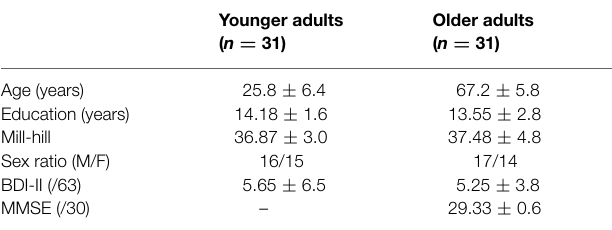
TABLE 1 | Participant demographic